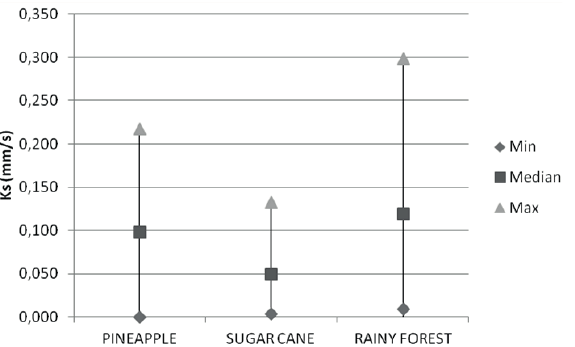
Fig. 3 Saturated hydraulic conductivity according land uses: mean, minimum and maximum values.